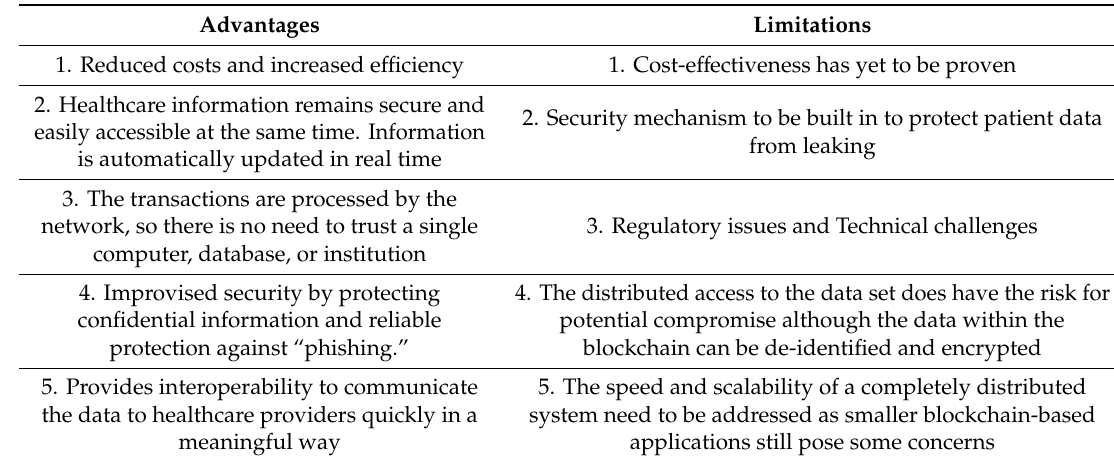
Table 1. Advantages and technical limitations of Blockchain